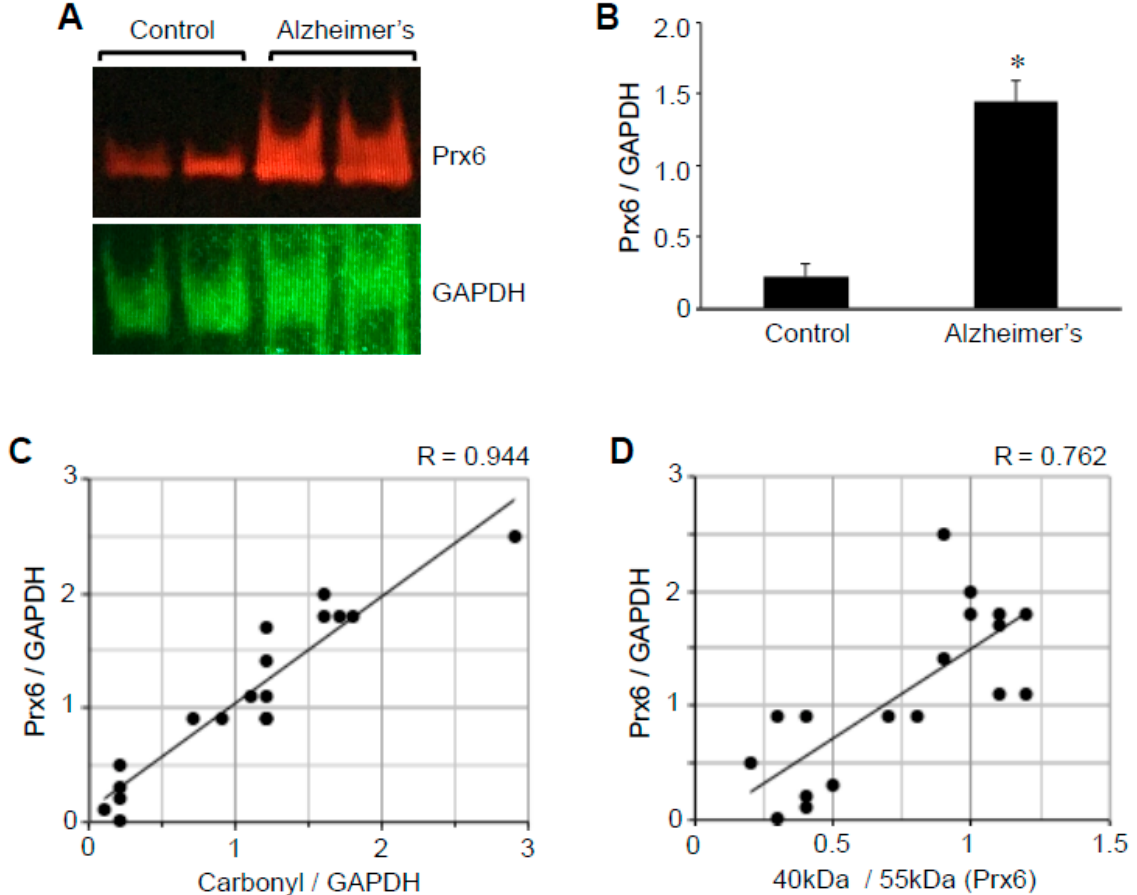
Figure 5. The Prx6 protein expression is upregulated in the brains of patients with Alzheimer’s disease. Brain (hippocampus) homogenates from control subjects and patients with Alzheimer’s disease were subjected to Western blotting using antibodies against Prx6 and GAPDH. ( A ) Representative results. ( B ) The bar graph represents means ± SEM of the ratio of Prx6 to GAPDH. The symbol * denotes that the value is significantly different from the control value at p < 0.05. ( C ) The scattered graph represents protein carbonylation vs. Prx6 expression (N = 18). Pearson correlation coefficient R = 0.944 (strong positive correlation). ( D ) The scattered graph represents Prx6 thiol oxidation vs. Prx6 expression (N = 18). Pearson correlation coefficient R = 0.762 (strong positive correlation).